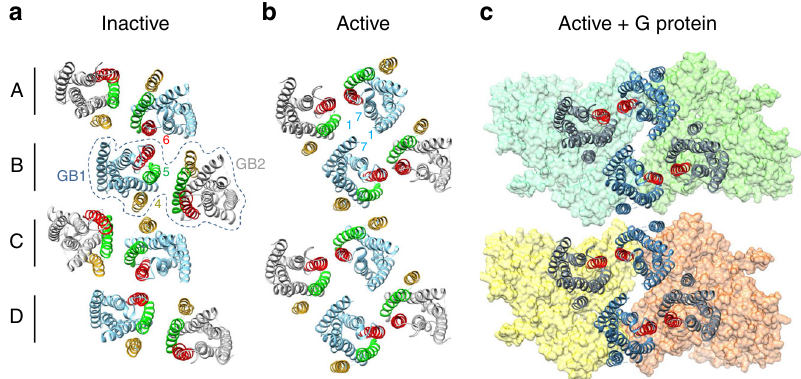
Fig. 9 Agonist-induced rearrangement of the 7TMs in the GABA B oligomer during activation. a , b 3D model of the 7TM oligomer in the inactive and active orientations. The dashed line highlights a minimal functional receptor made of GB1 and GB2 (heterodimer B ). Heterodimer A is proposed to assemble the tetramer with B , and C to form oligomer with the tetramer A - B . In this model, stabilization of the tetramer interactions is made by the symmetric interfaces with GB1 TM6 in the resting state, and with GB1 TM1 − TM7 in the active state. Stabilization of the oligomer would be through the symmetric interfaces with GB1 TM4 in the resting state and with GB1 TM4 − TM5 in the active state. TM4, TM5 and TM6 of GB1 and GB2 are in yellow, green and red, respectively. c Model of the active oligomer coupled to four G αβγ proteins based on the structure of the complex between the active β 2 -adrenergic receptor and the G protein previously reported